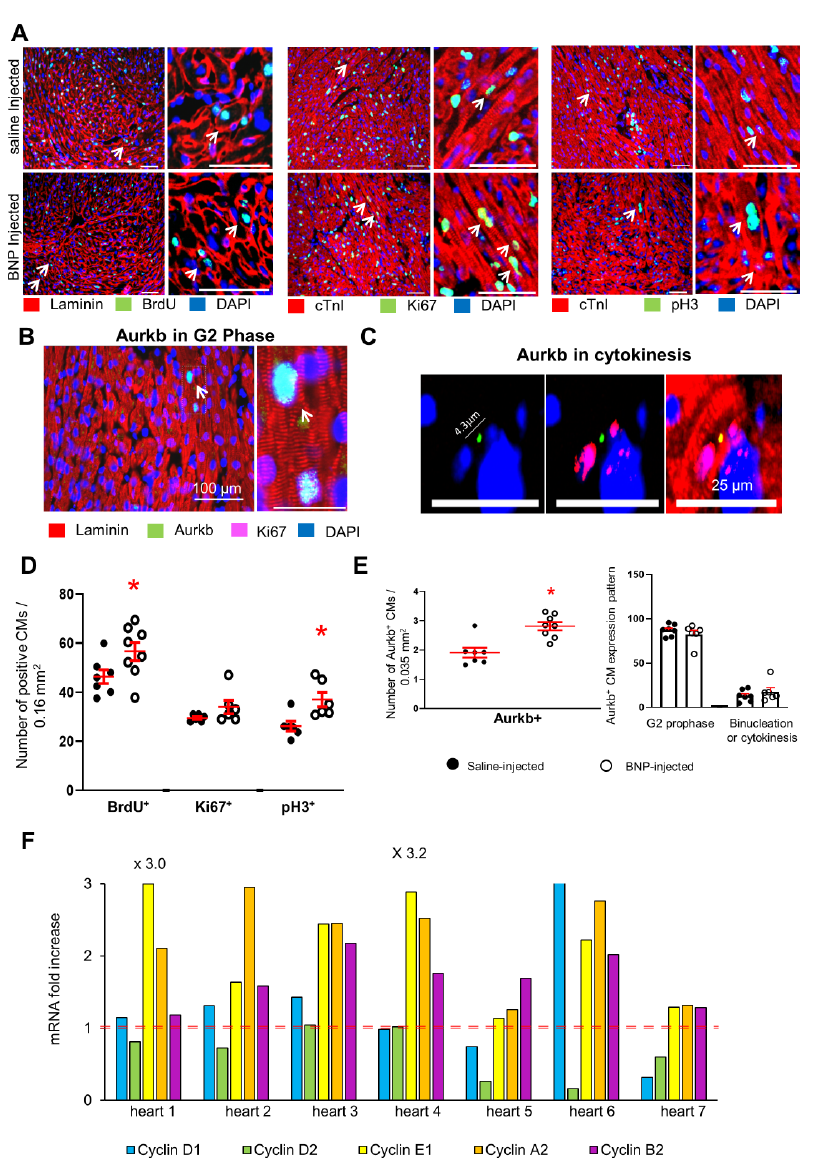
Figure 5. BNP injections into neonatal mice improve cardiomyocyte proliferation. ( A – C ) Repre- sentative pictures of immunostainings detecting CMs expressing BrdU, Ki67, phospho histone 3 (pH3) and Aurora B (Aurkb) in BNP and saline-treated neonatal hearts. Scale bars = 100 µ m in ( A , B ) and 25 µ mm in ( C ). ( D , E ) Number of CMs per picture expressing these proliferative markers. At least 10 dif- ferent pictures are analyzed per heart. n = 7 and 8 different saline-or BNP-injected hearts, respectively. (E) Within CMs expressing the Aurora B protein, the percentage of CMs in cytokinesis, binucleation or prophase was established. At least 70 Aurkb + CMs are analyzed per heart. Results are the means of the results obtained for 7 and 6 saline or BNP-injected hearts, respectively. ( F ) Expression of mRNAs coding for cyclin D1, D2, E1, A2 and B2. Results of CMs isolated from neonatal BNP-treated hearts expressed as a fold increase above the levels in CMs isolated from saline-treated hearts (represented by the red dotted line, n = 7 different isolations from saline- injected neonatal hearts). Seven different CM cell isolations from BNP-treated hearts represented. ( D , E ) individual values represented and the means ± SEM depicted in red. * p ≤